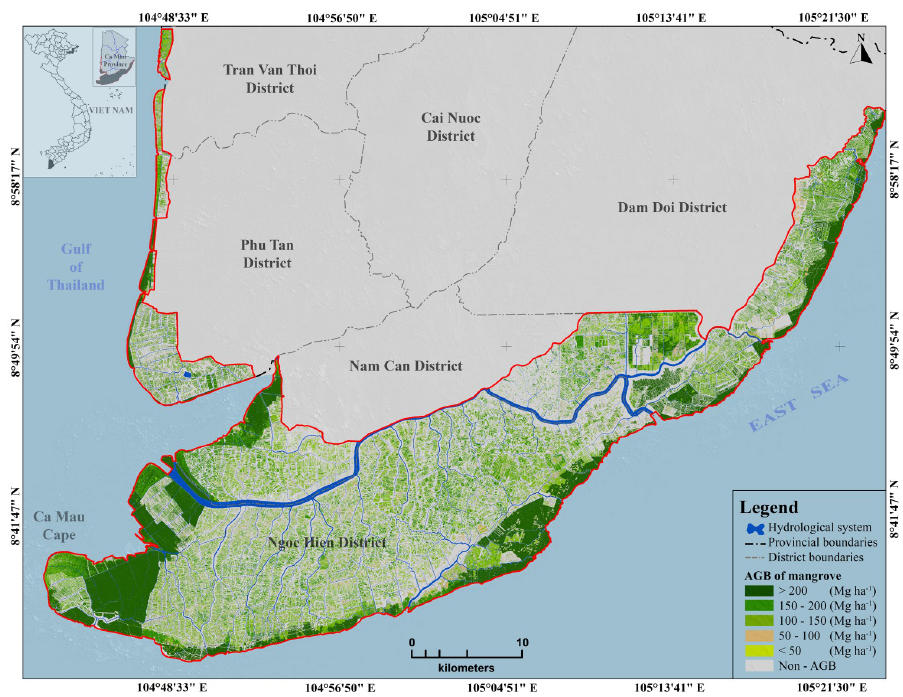
Fig 7. Mangrove aboveground biomass map of the study area. Background spatial data were collected from https:// gadm.org/ and processed by the authors.